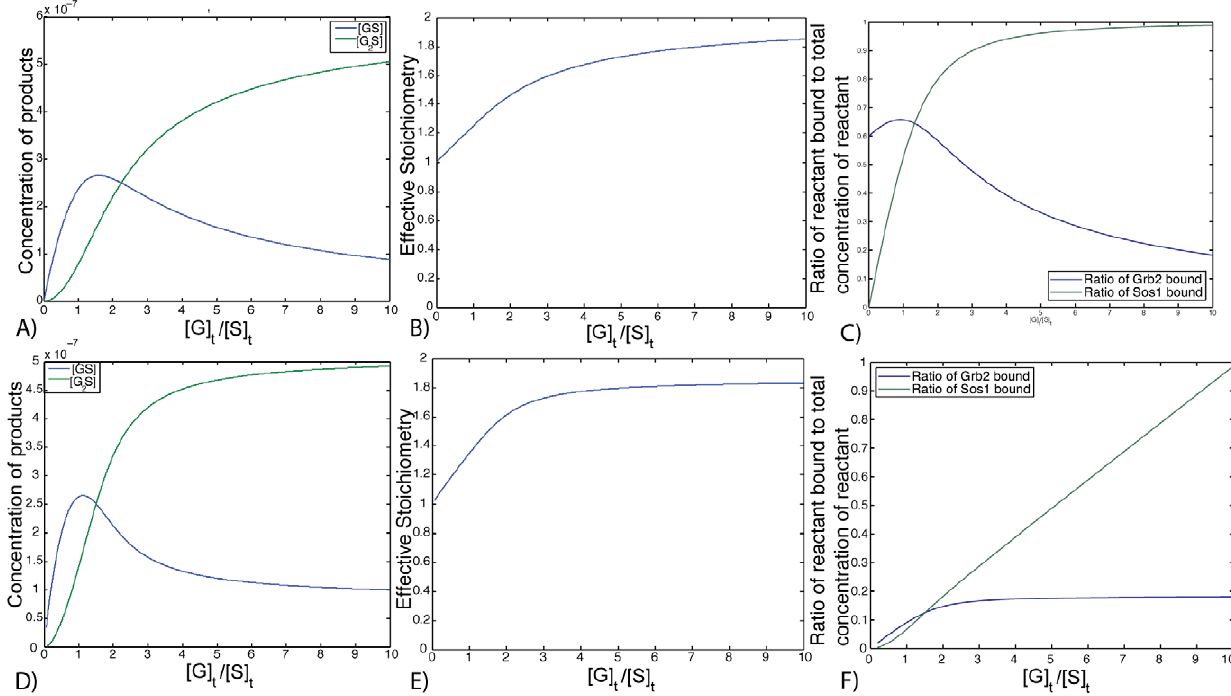
Figure 8. Stoichiometry of Grb2-Sos1 complexes at cellular concentrations. The concentration of Grb2 is increased at constant ~ 0 : 6 m M in A, B, and C. The concentration of Sos1 is varied at constant concentration of ½ G (cid:2) concentration of ½ S (cid:2) t concentration of products (A, D), effective stoichiometry (B, E), and ratio of bound to total concentrations of Grb2 and Sos1 (C, F) are plotted against the ratio of the concentration of reactants (Grb2 and Sos1).